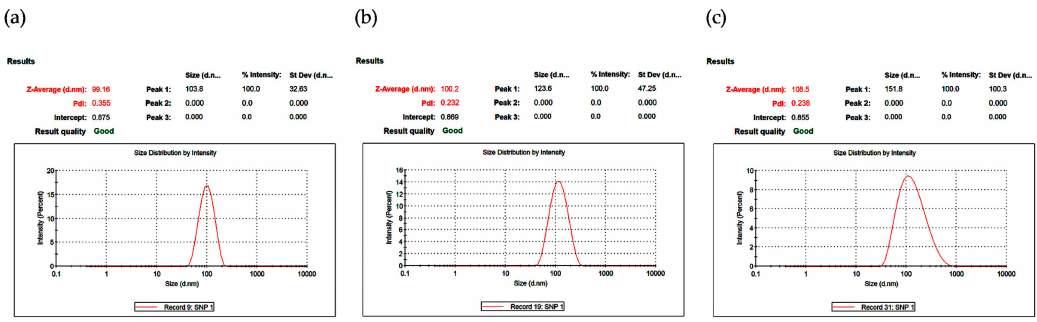
Figure 3. Particle size distribution curve of synthesized AgNPs at: ( a ) 24 h; ( b ) 48 h; and ( c ) 72 h.